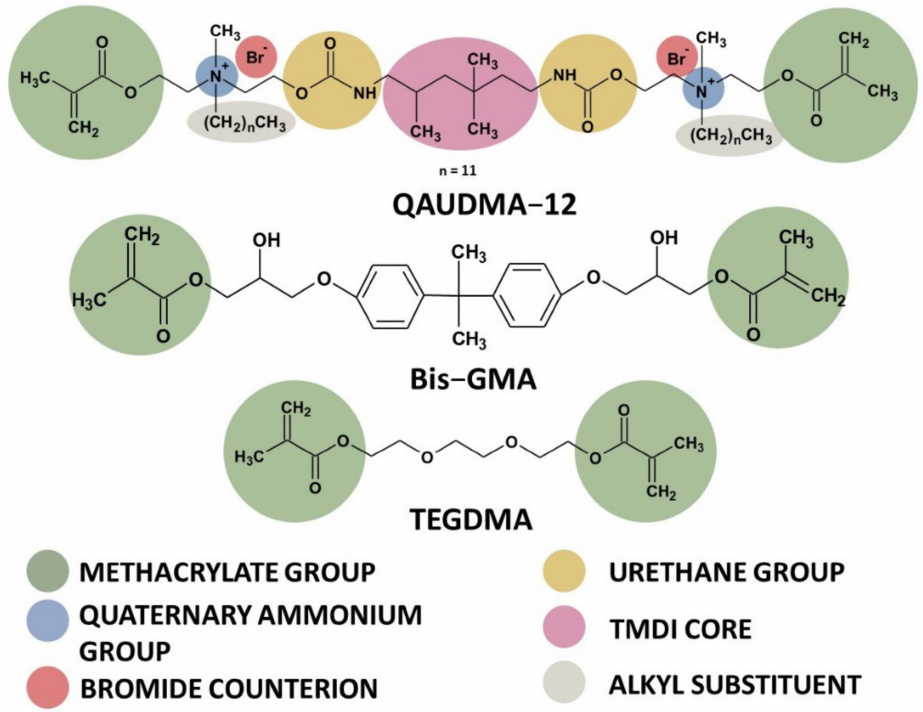
Figure 1. The chemical structure of the QAUDMA, Bis-GMA, and TEGDMA monomers used in this